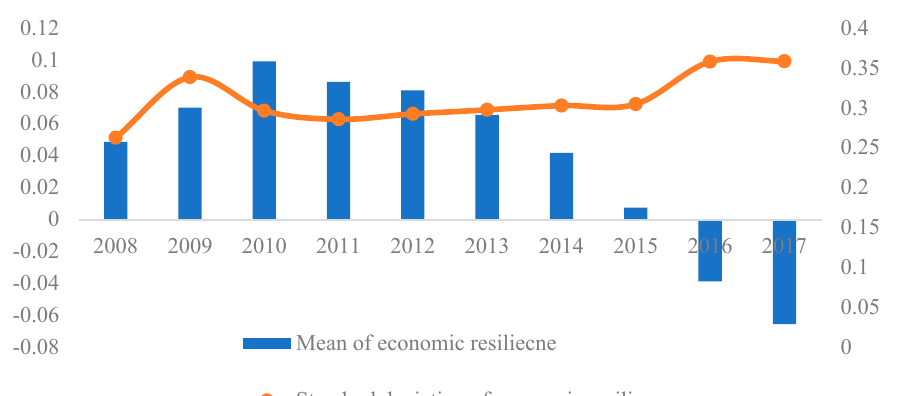
Figure 3. The mean and standard deviation of economic resilience of coastal areas in China.